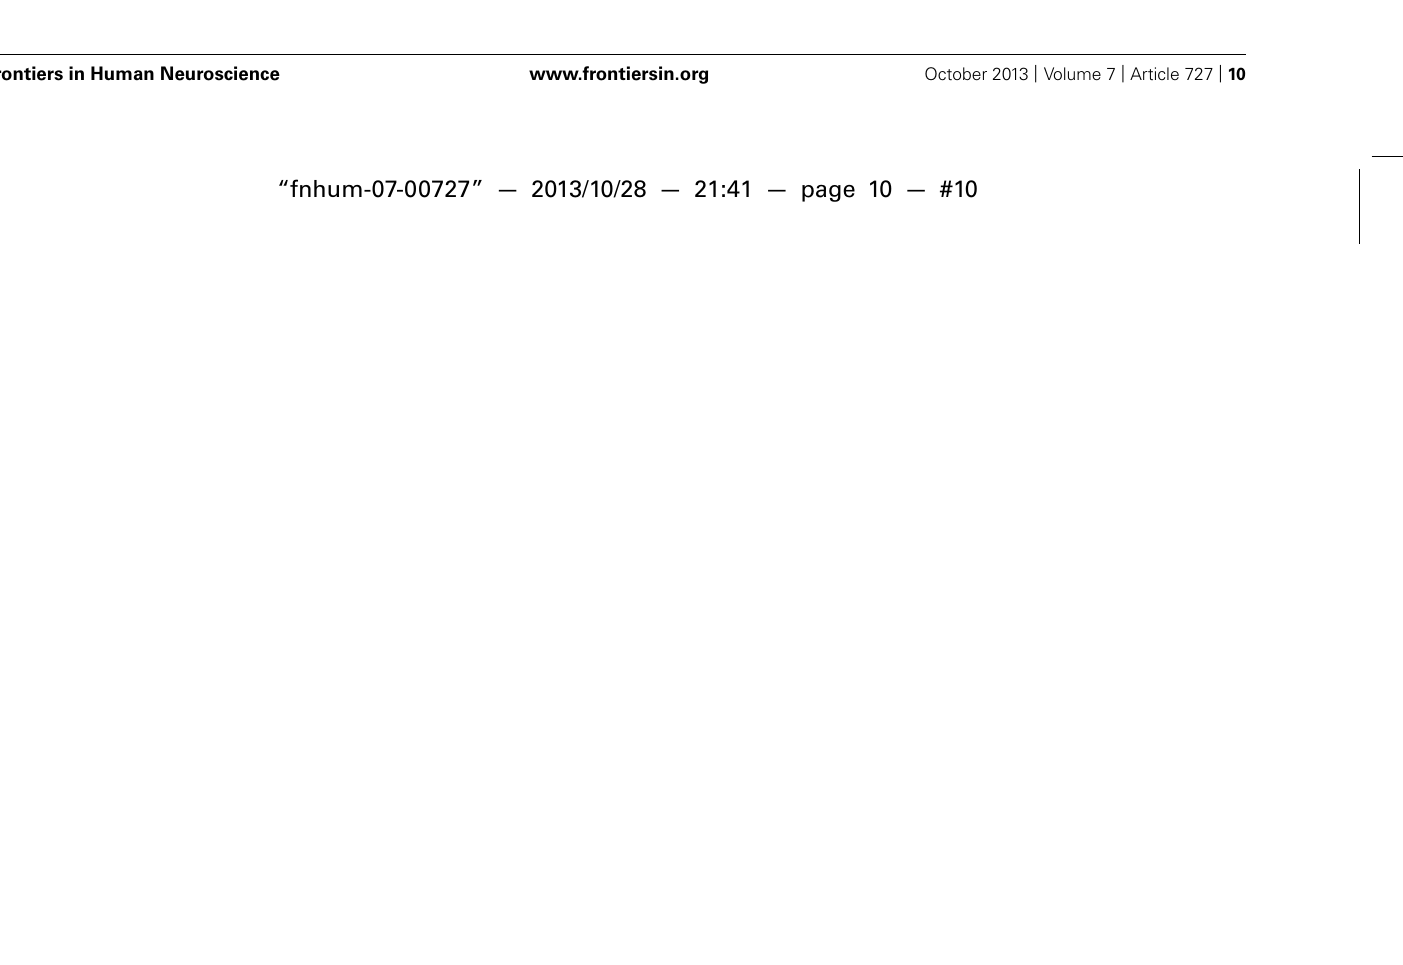
BPD (two-sample t -tests, p < 0.05, Bonferroni-corrected). See also Table 5 for correlation coefficients of significant inter-iFC. Results are controlled for antipsychotic medication. (B) For each subject, the ratio ( r ) of overall inter-iFC for CEN and SN within the intrinsic functional architecture of DMN, SN, and CEN was calculated by r = inter-iFC sum (CEN)/inter-iFC sum (SN), with inter-iFC sum for CEN and SN, respectively, reflecting summarized absolute z -values of inter-iFC.We found significantly reduced r in patients (two-sample t -test, ** p =